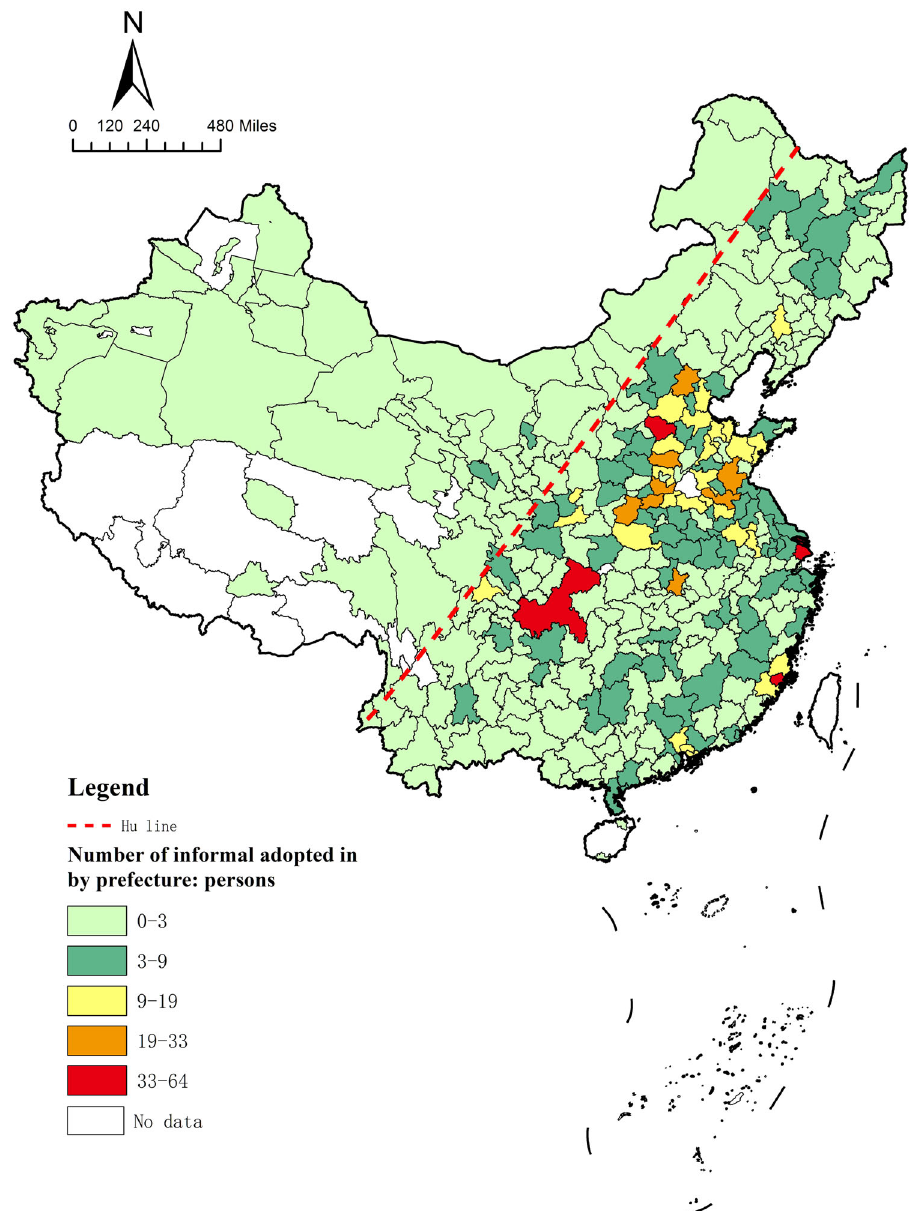
Fig. 6 Geographical distribution of informal in-adoptions for each city. Red indicates the largest number of children adopted into these cities, followed by orange, yellow, dark green, and light green. White indicates that the data are insuf fi cient for this province. The red dotted line is the dividing line of the population density in China, which is called the Hu